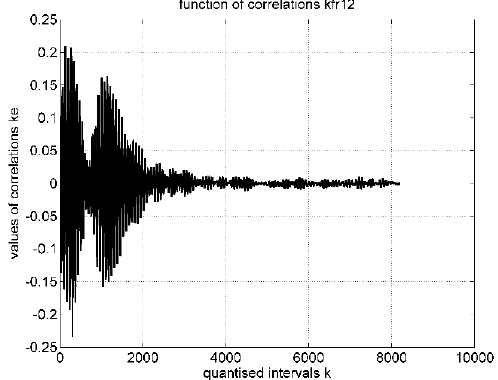
Figure 8. Normalized inter-covariance function of the 1st and 2nd vibration accelerations vectors.